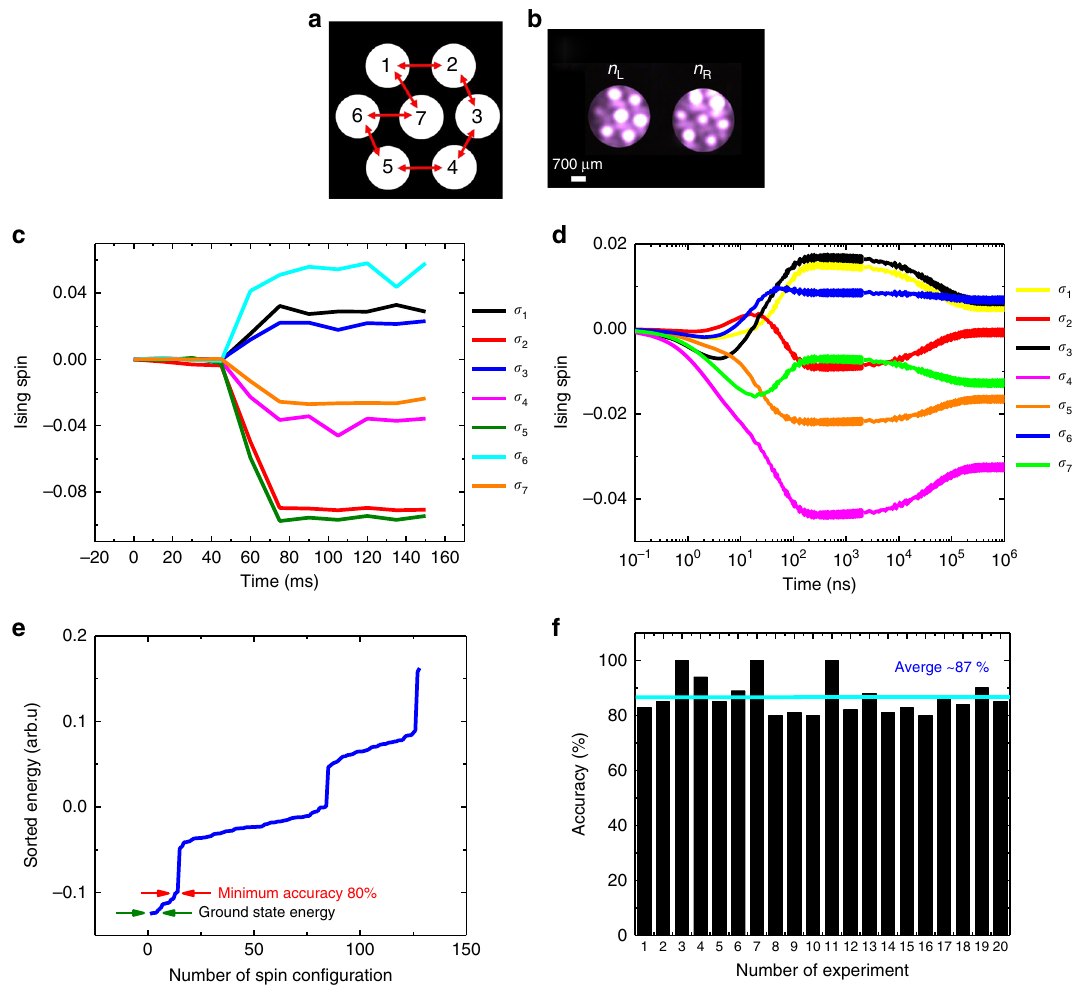
Fig. 7 One-dimension (1D) Ising Hamiltonian with N = 7. a A ring grating design for the mutual coupling with maximum two connections. b A picture of the facet from CCD when the Zeeman terms and mutual couplings were enabled. The intensity (brightness) of right and left circular polarizations change as the function of time. c Experimental Ising spin evolution as the function of time. d Simulation result of the proposed CIM and with a good agreement with Ising spin signs in c . e Sorted energy value versus all spin con fi gurations (2 7 ). f Accuracy versus number of experiment. The overall average accuracy of the CIM for this Ising Hamiltonian was